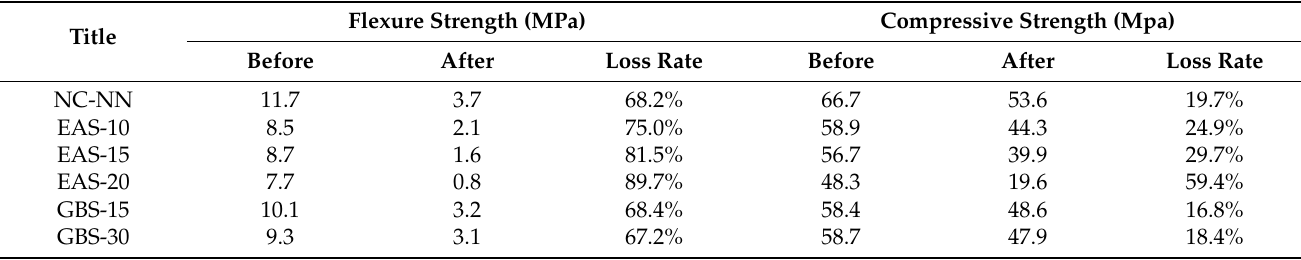
Figure 10. Results of rapid freezing and thawing resistance test: ( a ) relative dynamic modulus of elasticity; ( b ) ratio of mass change. Table 3. Properties of HSC containing slag after freezing and thawing